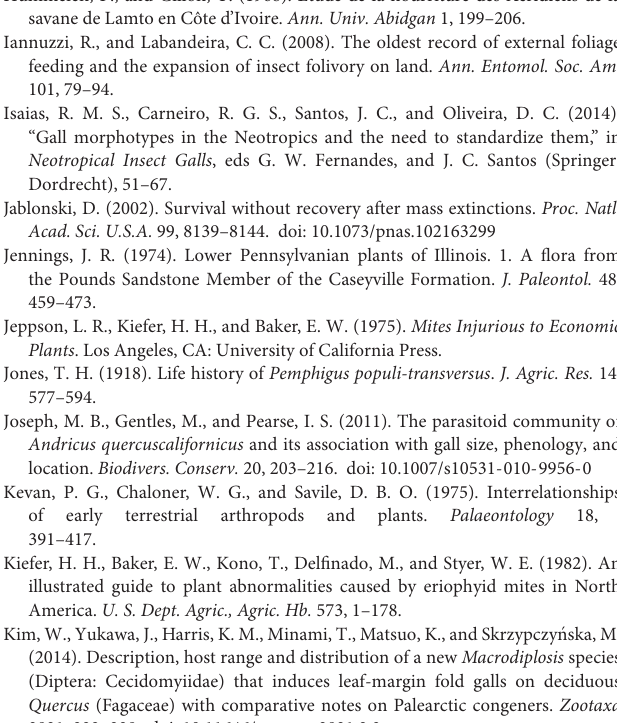
CarboniferousdivergencetimeformajorcladesofHolometabola. Entomol.Am. 117, 9–21. doi: 10.1664/10-ra-011.1